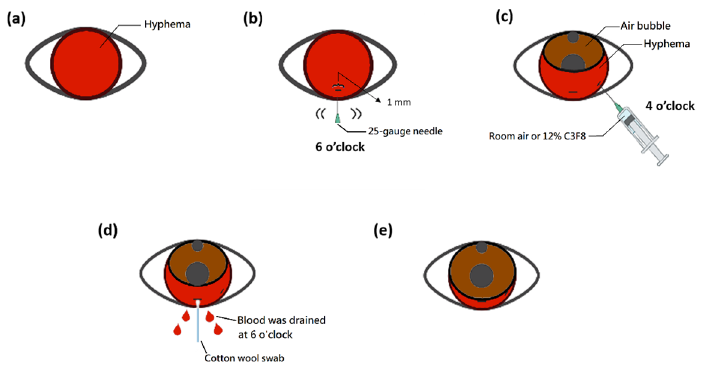
Figure 1. “Air–blood exchange under a slit-lamp” for the management of severe hyphema. This diagrammatic depiction was illustrated by one of the co-authors, I-Hung Lin and his colleague, Yi-Han Huang. ( a ) A patient with a blocked visual axis because of severe hyphema after filtering surgery. ( b ) After applying povidone-iodine solution and administering local anesthesia with proparacaine hydrochloride ophthalmic solution (Alcaine ® 0.5%, Alcon Laboratories, Fort Worth, TX, USA), the upper and lower eyelids were held in place with cotton wool swabs by an assistant, and the patient’s head was leant and fixed on the forehead rest by an assistant’s hand. We used a 25-gauge needle to stab and make horizontal extension to create a 1-mm clear cornea incision at the 6 o’clock position of limbal cornea. ( c ) A 1-cc syringe with a 25-gauge needle is filled with room air or 12% perfluoropropane (C3F8) and inserted through the inferotemporal limbal cornea of left eye or inferonasal limbal cornea of right eye, as close to the 4 o’clock position as possible, under a slit-lamp biomicroscope. Room air or 12% C3F8 is then injected through the syringe. ( d ) The syringe was then removed from the inferotemporal limbal cornea of the left eye or the inferonasal limbal cornea of the right eye. Then we used a cotton wool swab to gently push around the 1 mm clear cornea incision at 6 o’clock position under the slit-lamp. The blood in the anterior chamber was then drained from the clear cornea incision wound. ( e ) With this procedure, most of the hyphema was drained, and the anterior chamber was filled with air bubbles. The visual axis is clear without any blood clots.